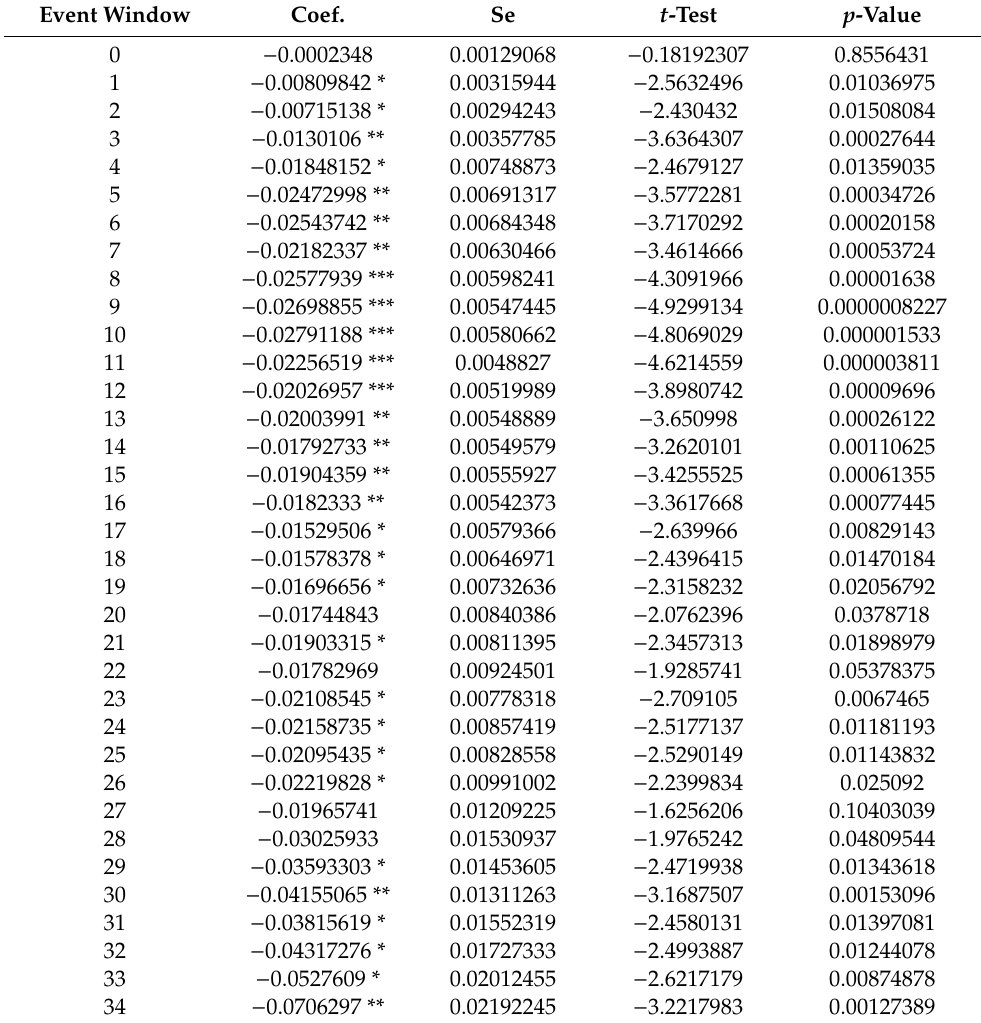
Table 10. Daily cumulative average abnormal return across all